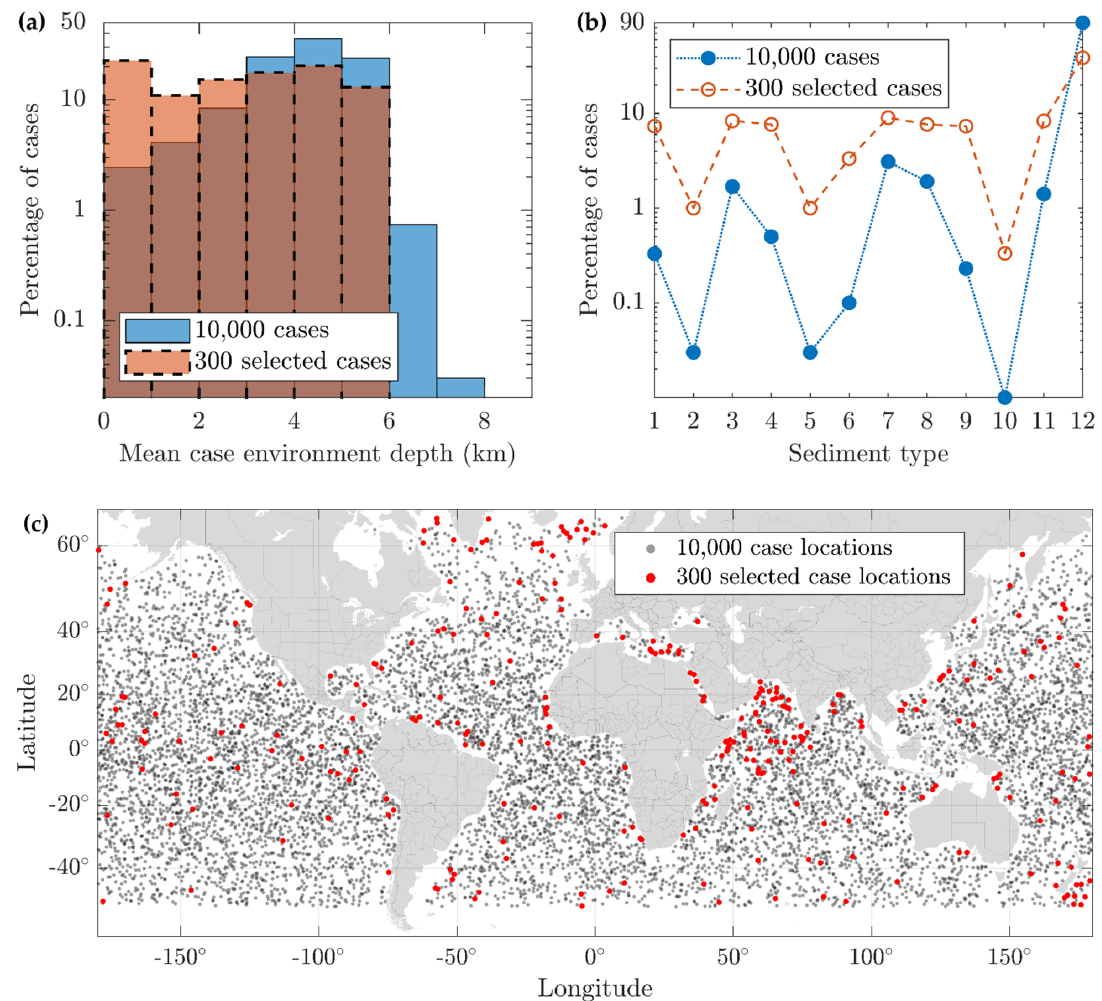
Figure 4. Summary of cases used to create the training and testing datasets. ( a ) The distributions of mean baseline environment depth for all 10,000 and the 300 selected cases. ( b ) The distributions of environment sediment type for all 10,000 and the 300 selected cases. The sediment types are—1: cobble or gravel or pebble, 2: muddy sandy gravel, 3: medium sand or sand, 4: fine sand or silty sand, 5: muddy sand, 6: gravelly mud or sandy silt, 7: medium silt or sand-silt-clay, 8: sandy mud or silt, 9: fine silt or clayey silt, 10: sandy clay, 11: silty clay, and 12: clay. Without careful selection of the final 300 cases, around 90% of the cases would have the clay sediment type. ( c ) Source locations for all 10,000 and the 300 selected cases.